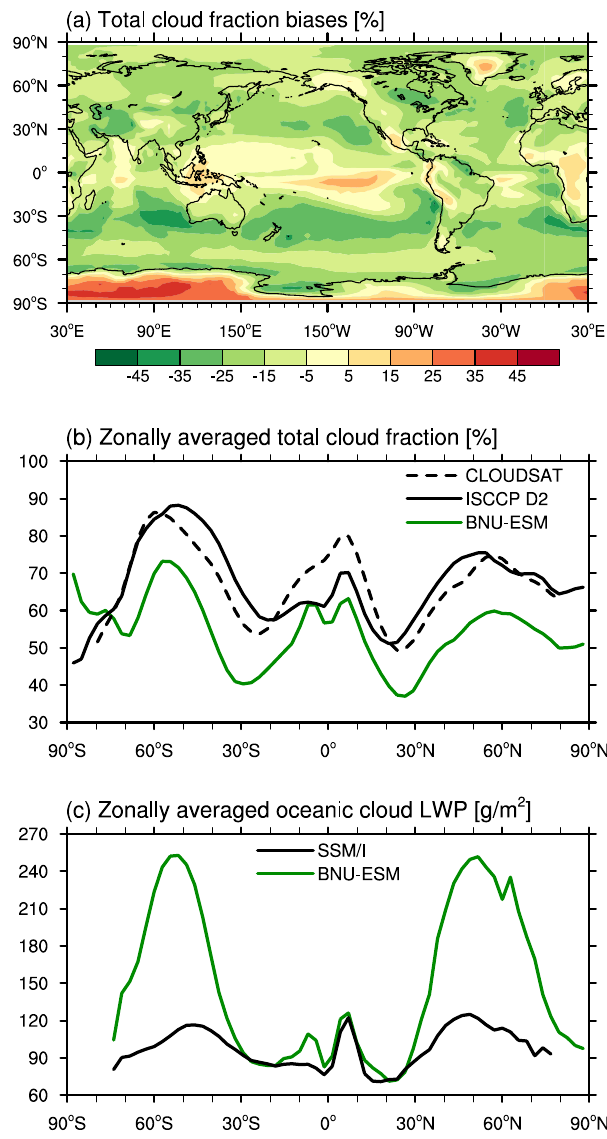
Figure 4. (a) Total cloud fraction bias relative to ISCCP D2 re- trievals (Rossow and Schiffer, 1999; Rossow and Dueñas, 2004). (b) Zonally averaged total cloud fraction compared with ISCCP D2 re- trievals and CLOUDSAT retrievals (L’Ecuyer et al., 2008). (c) Zon- ally averaged total liquid water path (LWP) compared with Special Sensor Microwave/Imager (SSM/I) retrievals (Wentz, 2000, 2013) over